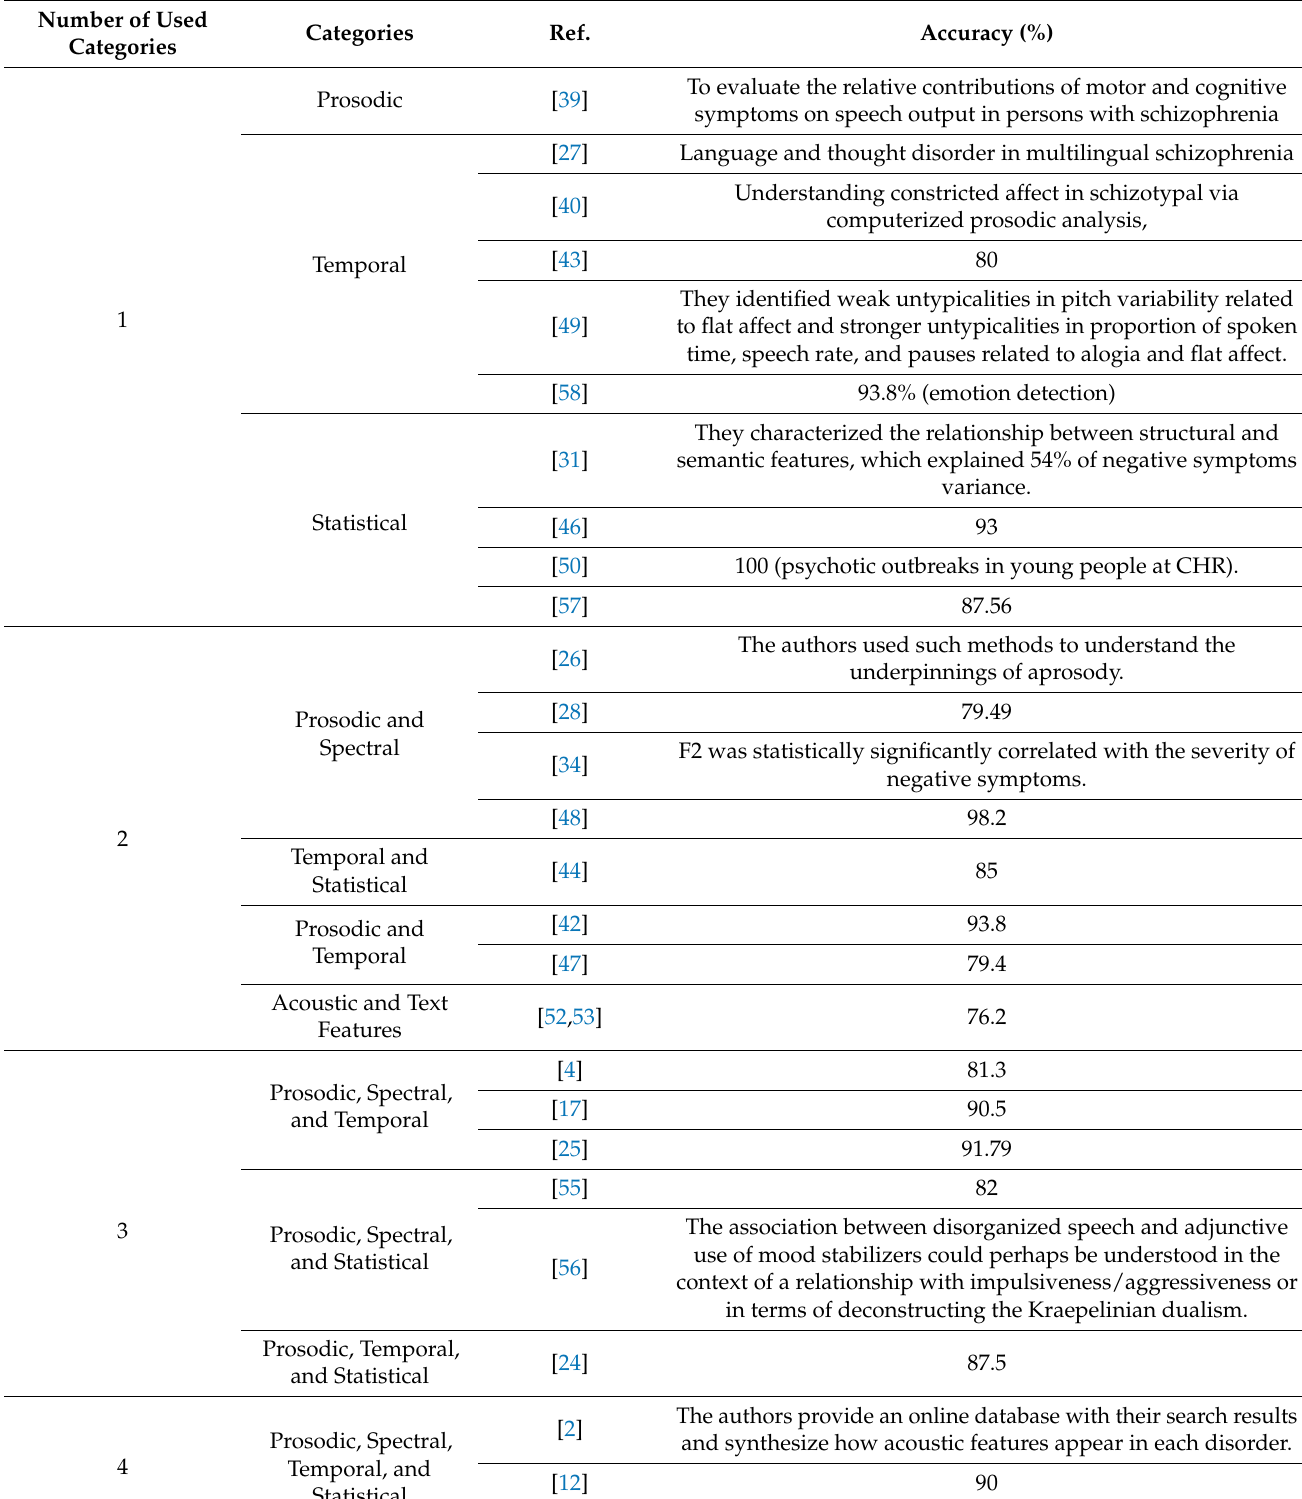
Table 2. Accuracy of the speech features in the